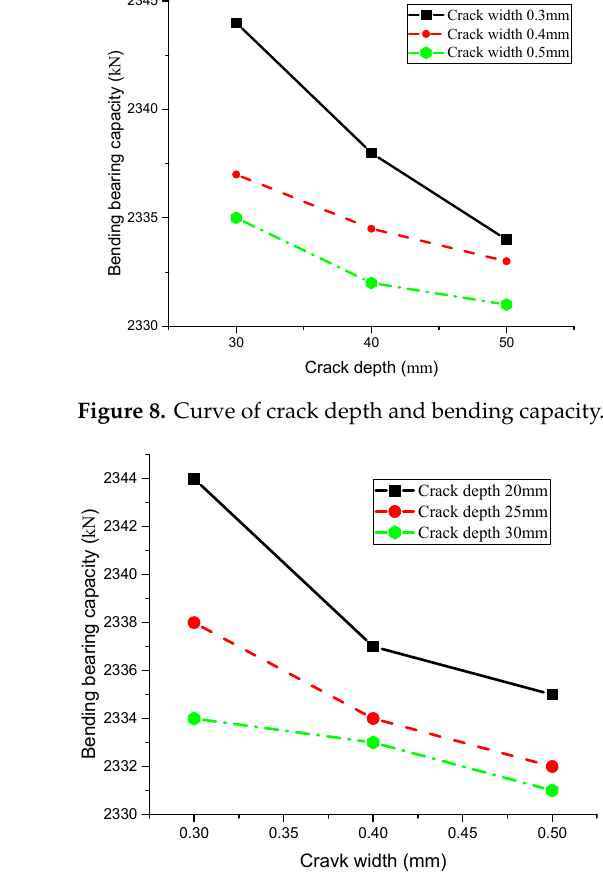
Figure 9. Curve of crack width and flexural capacity.